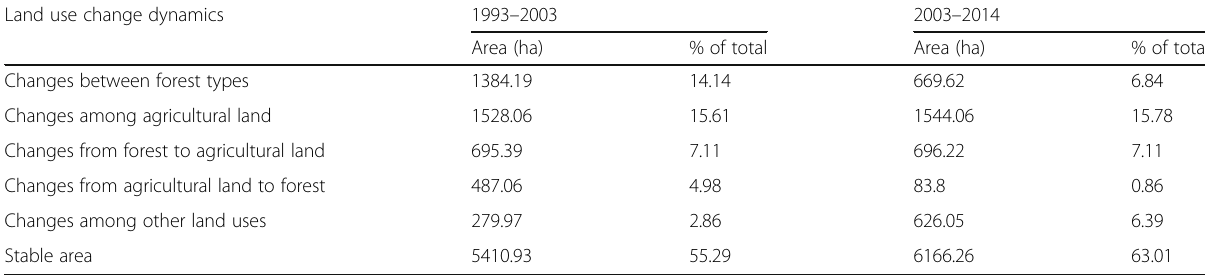
Table 8. Effect of major land use change on SOC stock